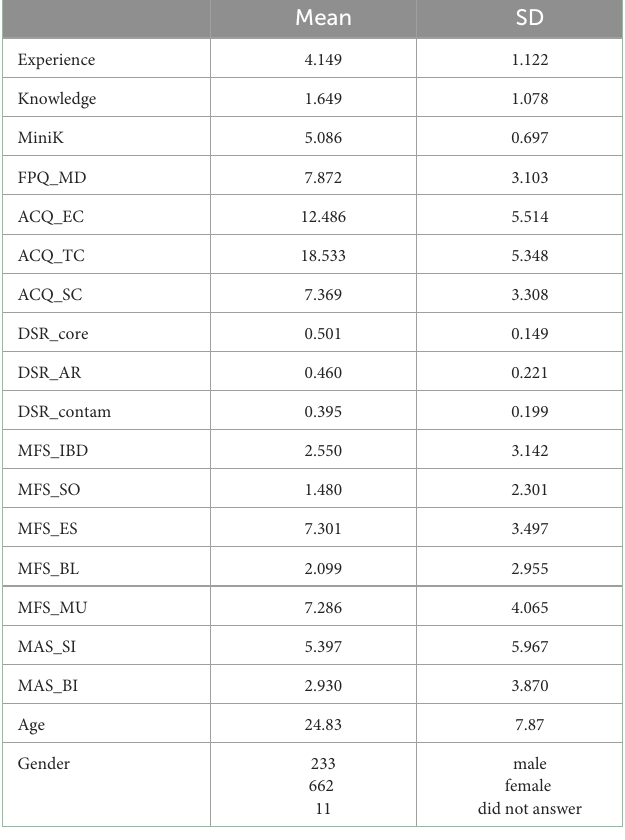
TABLE 1 Descriptive statistics (means and standard deviations – SD) of the sample on disgust sensitivity (DS) core, animal remainder (AR), contamination; medical fear survey (MFS) injection and blood draw (IDB), sharp objects (SO), examinations and symptoms (ES), blood (BL), mutilation (MU); fear of medical/dental pain (FPQ MD); life history strategy variation (Mini-K); perceived control (ACQ) emotion (EC), threat (TC), and stress (SC); medical avoidance (MAS); age; number of respondents (separately for